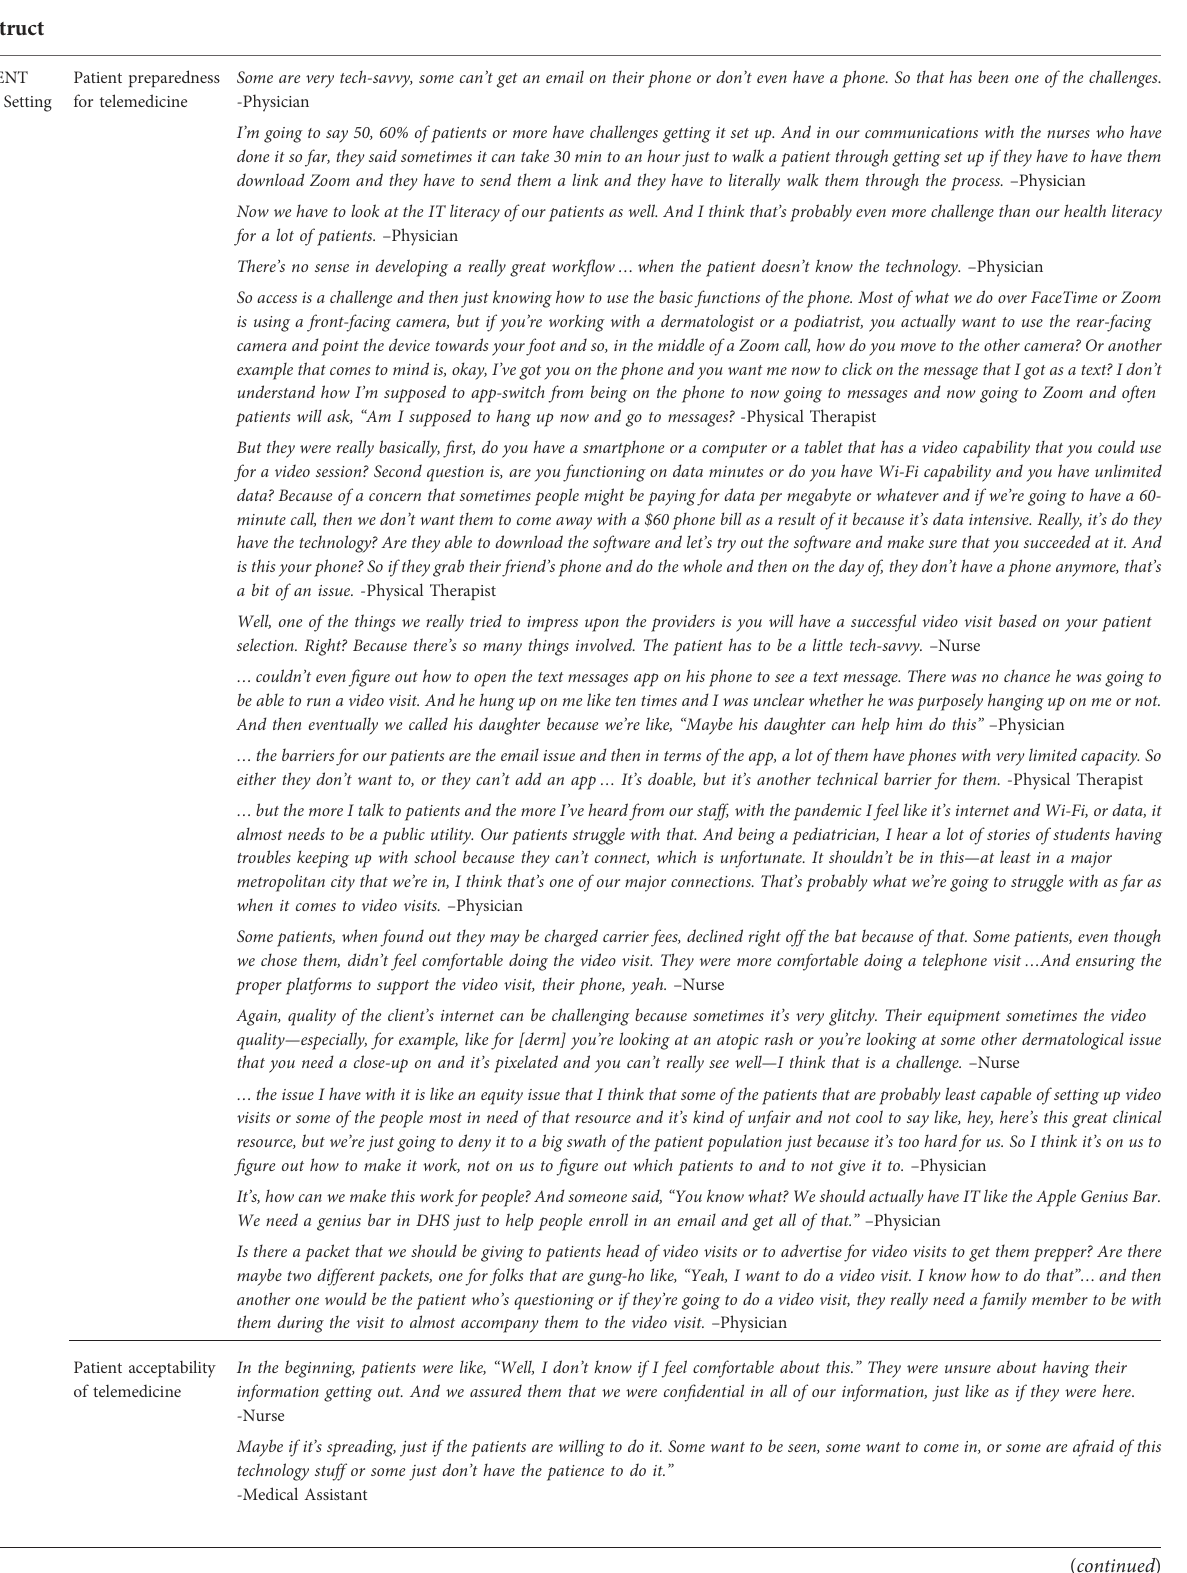
TABLE 2 Multilevel themes addressing telehealth implementation in the safety